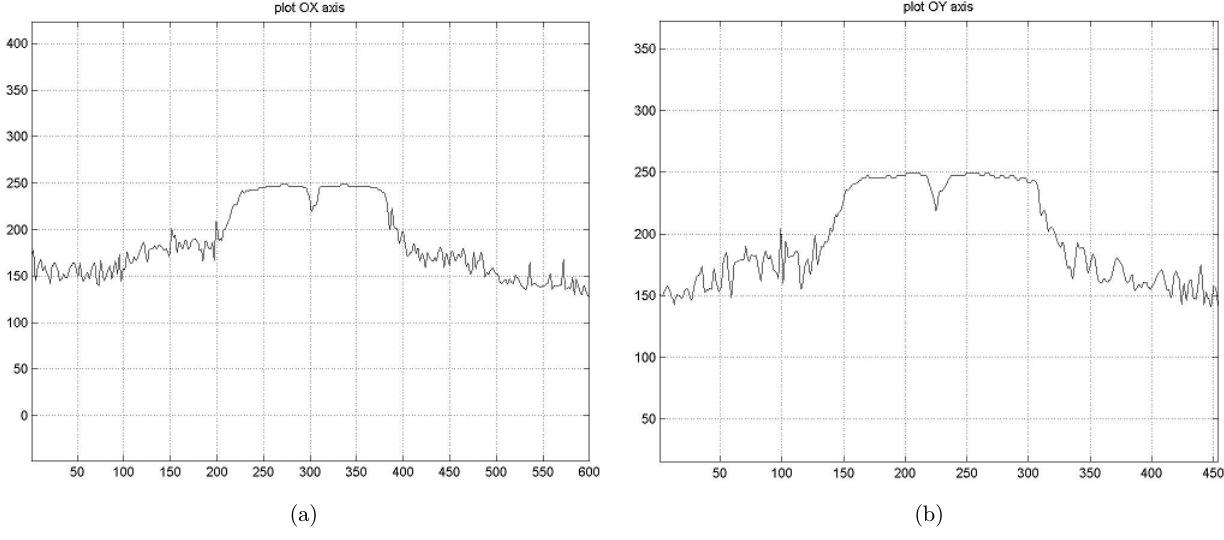
Fig. 6. The distribution of light intensity on the observation screen for the di®raction pattern shown in Fig. 4(e). The vertical axis — the light intensity (in arbitrary units). The horizontal axis — coordinate of the point on the observation screen (in arbitrary units) relative to the horizontal axis (a) and to the vertical axis